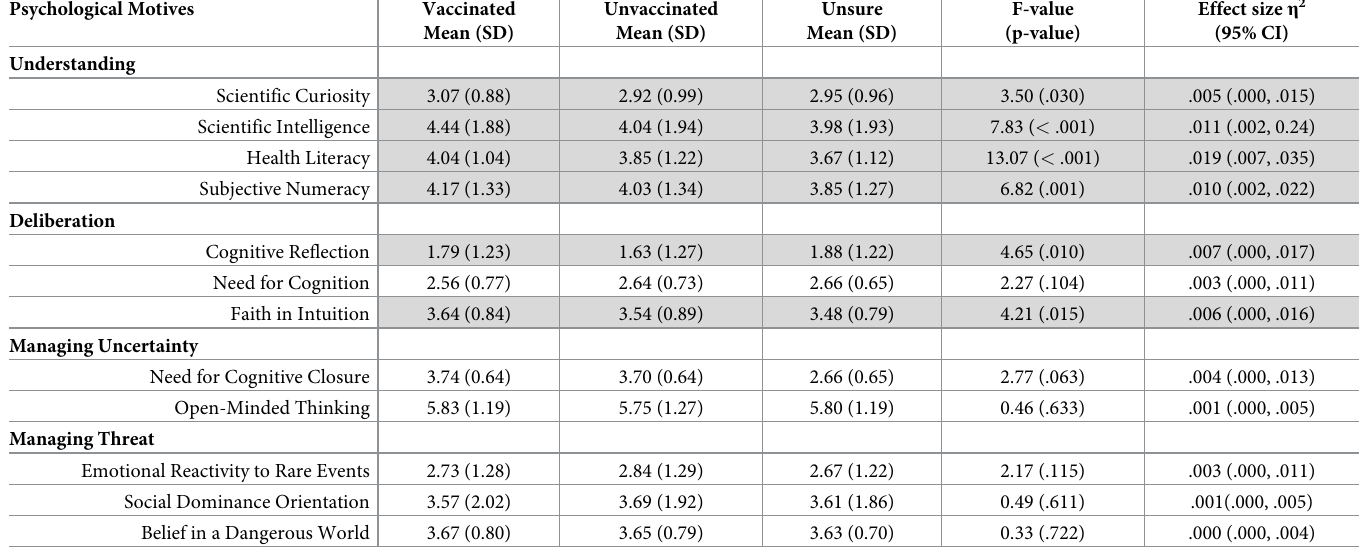
Table 4. One-way ANOVAs testing for differences in measures based on vaccination status.